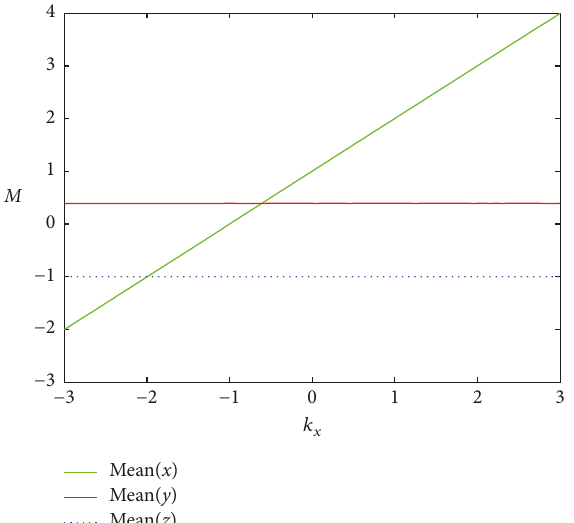
Figure 6: Average values of three variables ( 𝑥,𝑦, 𝑧 ) for 𝑘 𝑥 ∈ [−3,3] .